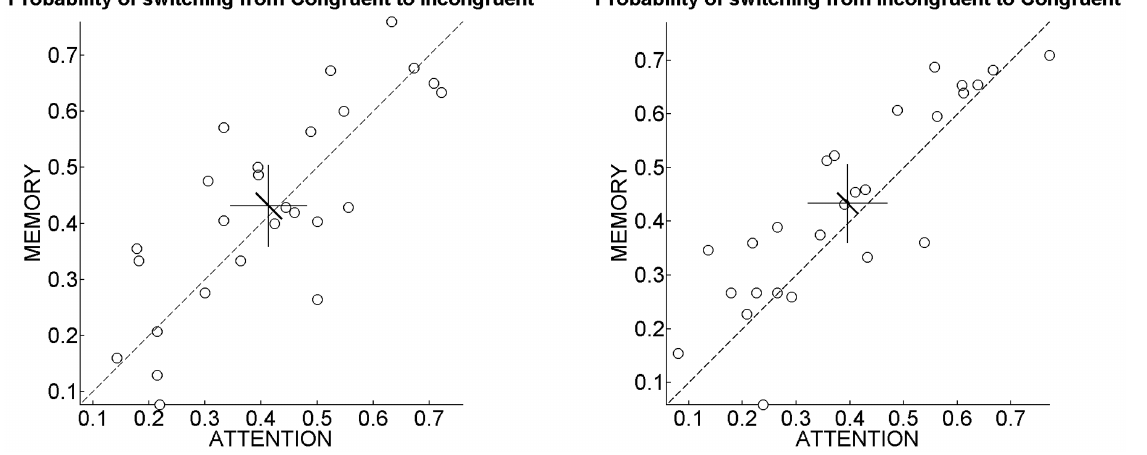
Figure 5. Probability of switching. Left panel : Probability of switching from perceiving the same direction of motion as the unambiguous stimulus to perceiving the opposite direction. Right panel : Probability of switching from perceiving the opposite direction of motion than the unambiguous stimulus to perceiving the same direction. Probability was computed by diving the number of switches between alternative percepts by the number of episodes across trials, separately for each subject and condition. Performance in the memory condition is plotted as function of the attention condition. Vertical and horizontal error bars represent 95% confidence intervals within the WM and the attention condition respectively. Diagonal error bars indicate the between-observers 95% confidence interval of the distance from the bisector. The coordinates of the crossing points of the bars represent the means of the WM and attention conditions, computed across participants. The probability of switching from an incongruent to a congruent percept was higher in the WM condition as compared to the attention control condition.